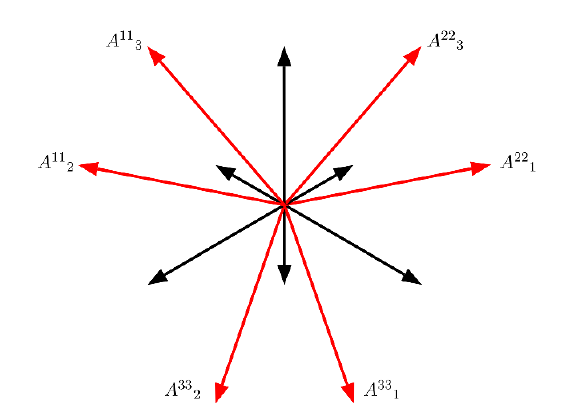
Figure 2 . The 15 of SL(3 ; R ) to which the 8-forms belong. The longest weights are painted in red, and for each longest weight we have written the corresponding component of the potential. For simplicity the space-time indices are omitted. The shortest weights have multiplicity